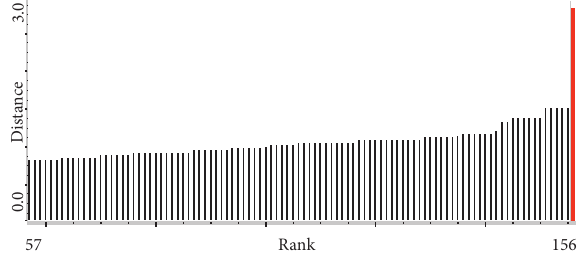
Figure 4: The PCR model of moisture content’s spectrum outlier selected according to Mahalanobis